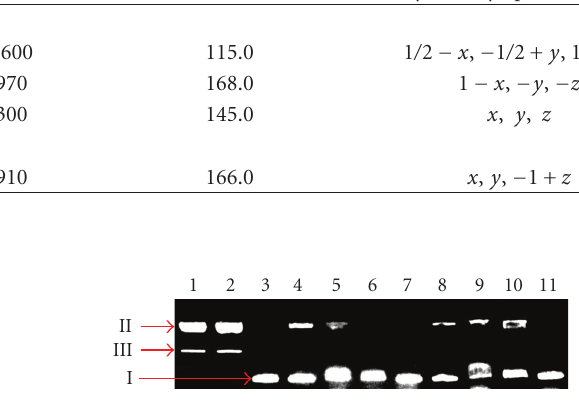
Figure 5: Agarose gel electrophoresis pattern of pDNA in the presence of the synthesized complexes and (3-py)CHNOH in various concentrations. Lane 1, DNA + 1 · H 2 O (5mM); lane 2, DNA + 2 (5mM); lane 3, DNA+ (3-py)CHNOH (5mM); lane 4, DNA + 1 · H 2 O (2.5mM); lane 5, DNA + 2 (2.5 mM); lane 6, DNA + (3-py)CHNOH (2.5mM); lane 7, DNA + 1 · H 2 O (1mM); lane 8, DNA + 2 (1mM); lane 9, DNA + 1 · H 2 O (0.1mM); lane 10, DNA + 2 (0.1mM); lane 11, DNA control.